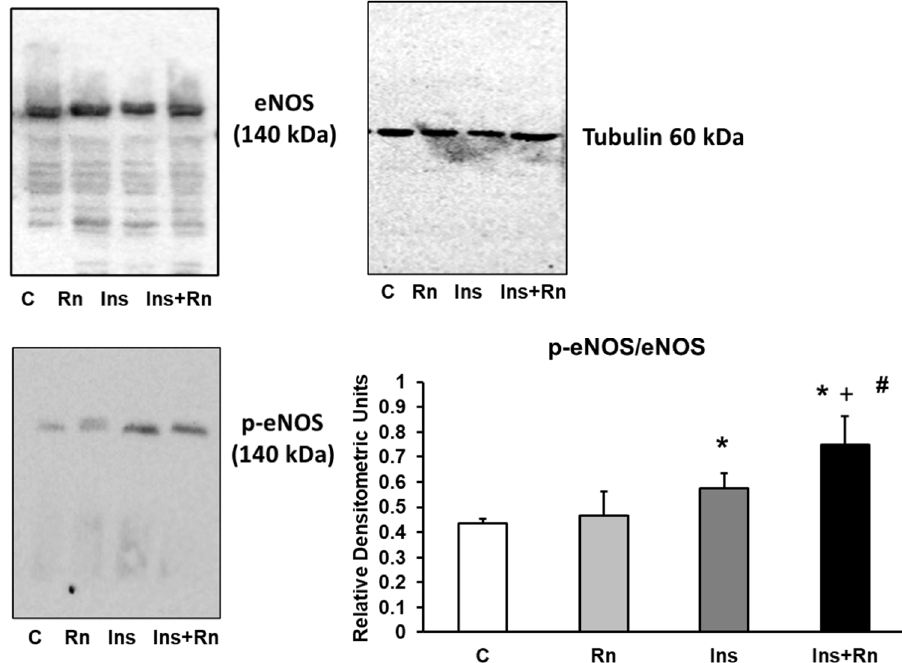
Figure 4. Effect of Ins and Rn on p-eNOS and eNos protein expression. Astrocytes were incubated without Ins or Rn (control, C), with Rn (10 − 6 M), with Ins (10 − 8 M), or with Ins + Rn (10 − 8 M + 10 − 6 M) for 24 h and collected to determine p-eNOS (1:250), eNOS (1:250), and Tubulin (1:3000) protein expressions by Western blot. A representative immunoblot is shown in the panel. Data are mean ± SD of four independent experiments (four different rats). * p < 0.05 vs. control. + p < 0.05 vs. Rn. # p < 0.05 vs. Ins.